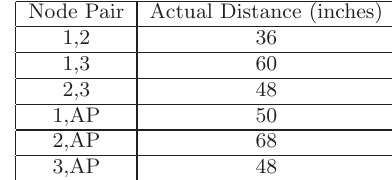
Table 6: Indoor Pairwise distance by physical mea- surements